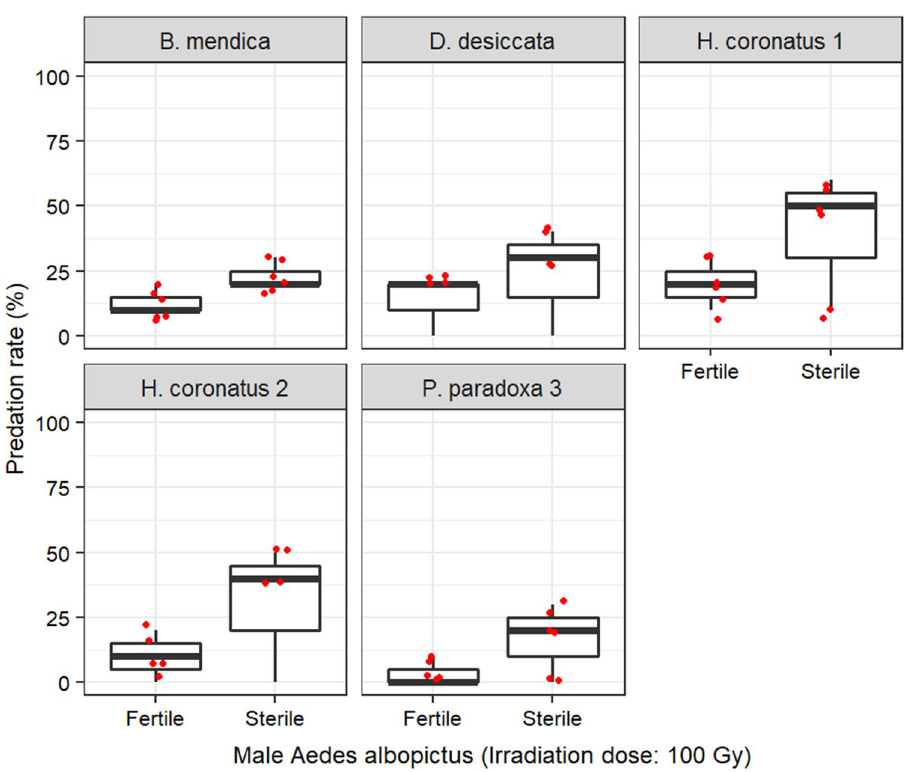
Figure 3. Vulnerability of fertile versus sterile male Aedes albopictus (irradiated at 100 Gy) to mantis